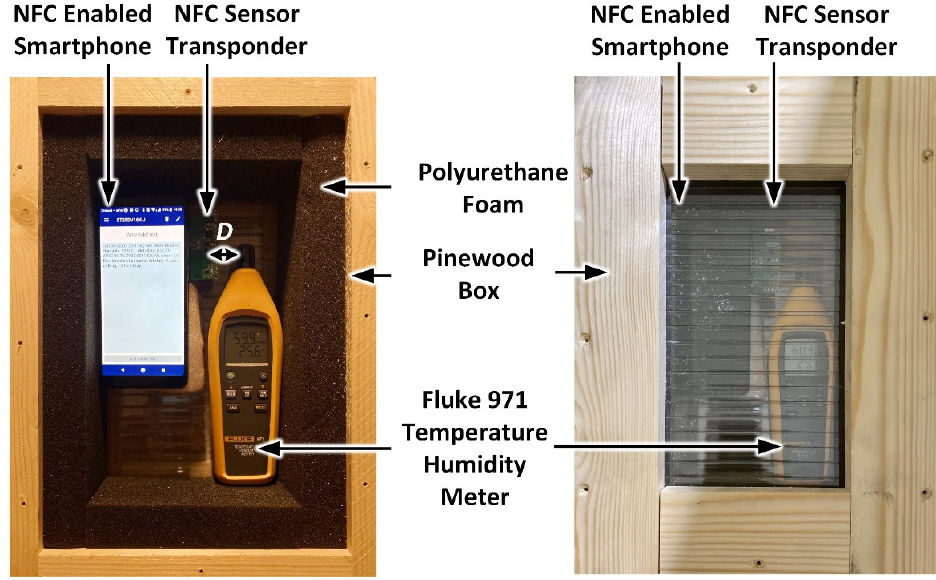
Figure 7. NFC sensor temperature and relative humidity measurement setup. Initially, the NFC sensor, along with the smartphone (Vodafone X9) and Fluke 971 meter were placed within the enclosure for a period of 60 minutes. During NFC sensor measurements, the transparent lid of the pinewood box was removed and the smartphone was placed over the NFC sensor to capture the measured temperature and relative humidity of the NFC sensor within a period of less than one minute. The measured temperature and relative humidity for the Fluke 971 meter were also recorded and the lid was subsequently closed. Using this approach, 10 measurements for temperature and relative humidity were taken over a one-hour period. During measurements, the ambient lab temperature and relative humidity varied between 24.6 °C to 26.5 °C and 59.9% to 63.8%, respectively. The measured temperature and relative humidity errors between the NFC and calibrated meter measurements are shown in Figure 8. Figure 8a shows that a mini- mum error of 0.2 °C and a maximum error of 0.6 °C was recorded. Similarly, the measured relative humidity results are shown in Figure 8b with a minimum error of 0% and maxi- mum error of 0.7% being recorded. The above results show that the NFC sensor exhibited a mean error of 0.37 °C and a standard deviation of 0.106 °C in temperature and a mean error of ± 0.35% and a standard deviation of 0.321% in relative humidity. In Figure 8, the vertical bar symbols (in black) represent the magnitude of standard deviation and the blue square symbols denote the mean error value.